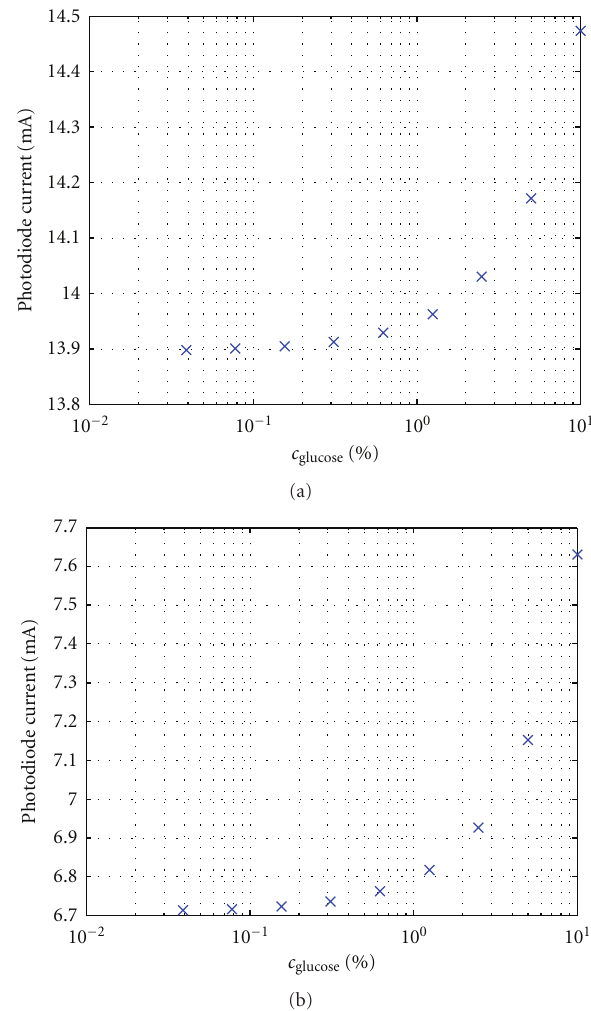
Figure 9: Photodiode current over wavelength deviation Δ λ for the dipole metamaterial (a) and for the EIT metamaterial (b).